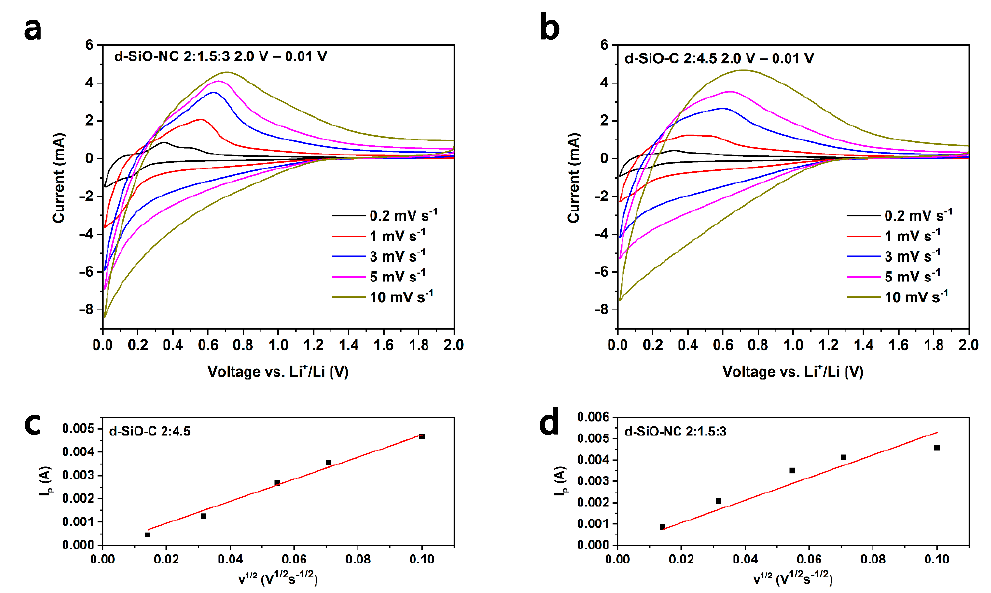
Figure 9. Cyclic voltammetry curves of d-SiO-C (2:4.5) ( a ) and d-SiO-NC (2:1.5:3) ( b ) in different scan rate. Peak current, I p as a function of square root of scan rate, v 1/2 of d-SiO-C (2:4.5) ( c ) and d-SiO-NC (2:1.5:3) ( d